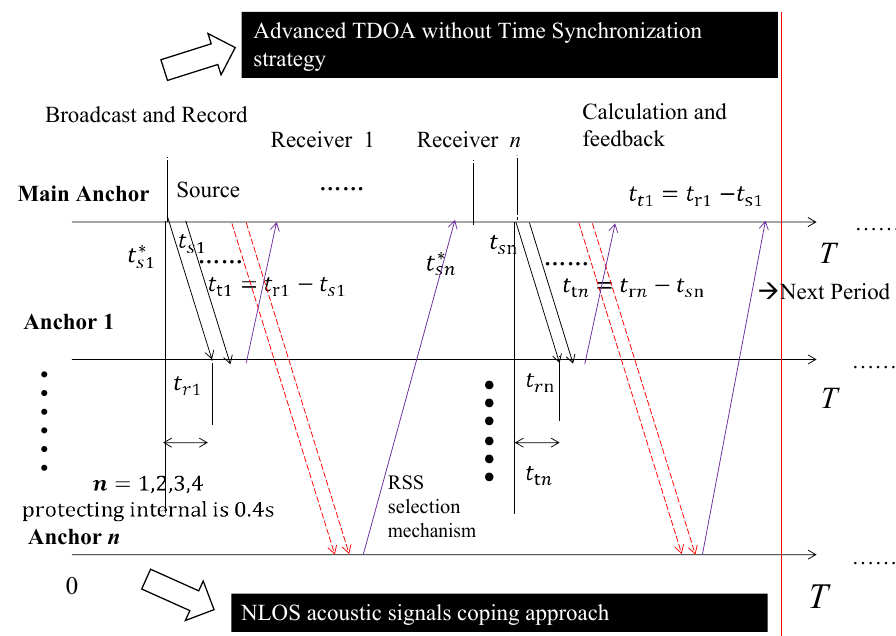
Figure 1. Dual-receiving signal processing